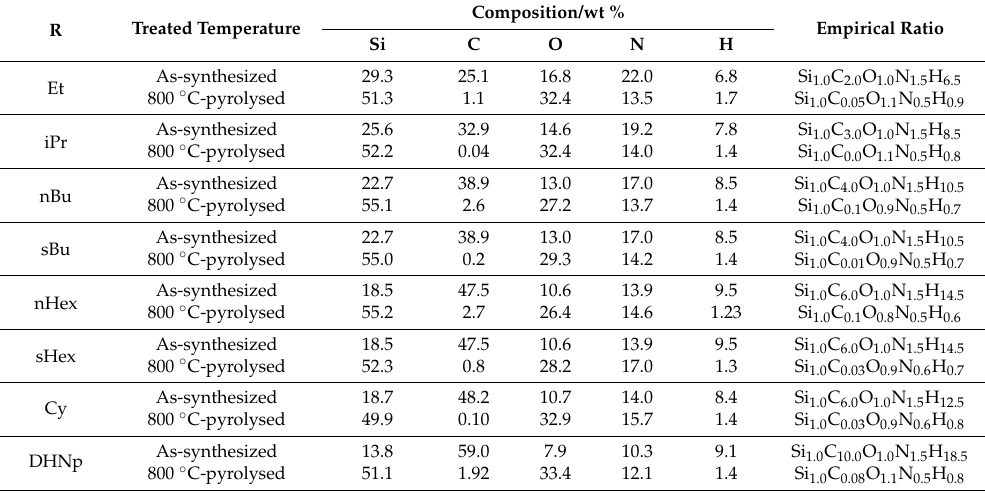
Table 3. Chemical composition of 800 ◦ C-pyrolyzed ROSZ samples.